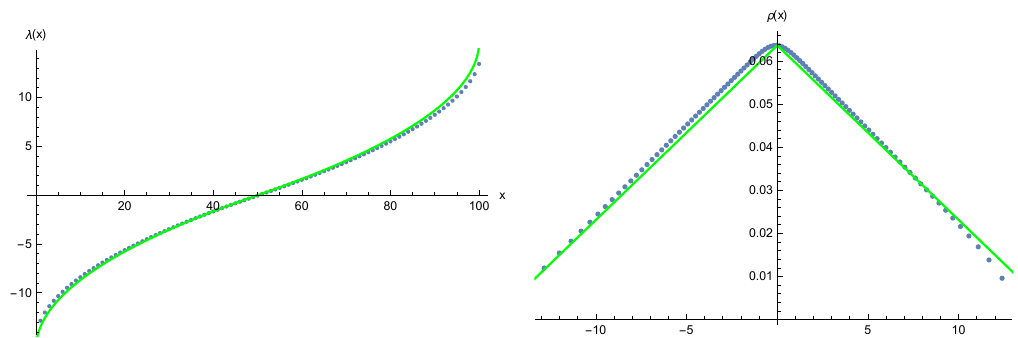
Figure 5 . The left (cid:12)gure shows the comparison of the numerical solution (Blue dots) of the saddle point equation of (D.1) with the analytic solution (D.23) (Green line). The right one shows that the comparison of the density function from numerical analysis(Blue dots) with the analytic one (Green line). In this (cid:12)gures we focus on the eigenvalues of the (cid:12)rst N valuable x by m